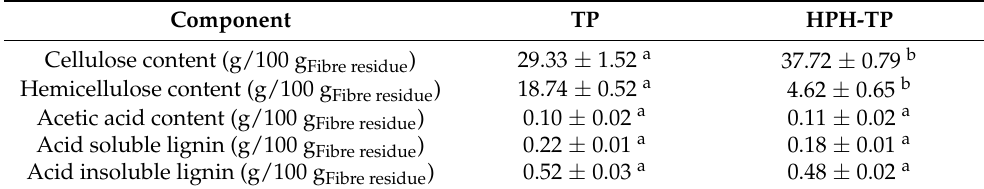
Table 3. Lignocellulosic fractionation process of TP and HPH-TP in terms of cellulose, hemicellulose, and lignin